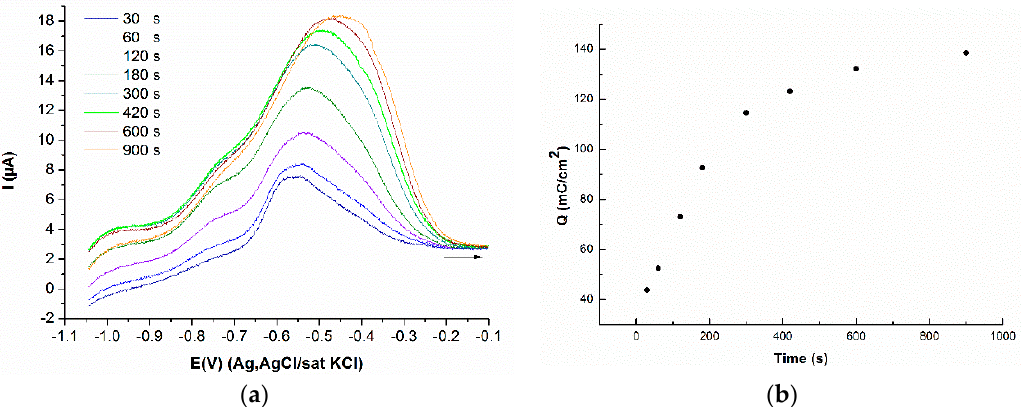
Figure 3. ( a ) Anodic stripping curves of Mo deposited at E = − 0.75 V on Ag (111) in NaOH 0.1 M. The scan rate is 50 mV·s − 1 . The curves refer to deposition times from 30 s to 15 min ( b ) Plot of the charges, Q, involved in the stripping of Mo deposited on Ag(111), as a function of the accumulation time, at a constant deposition potential of − 0.75 V.